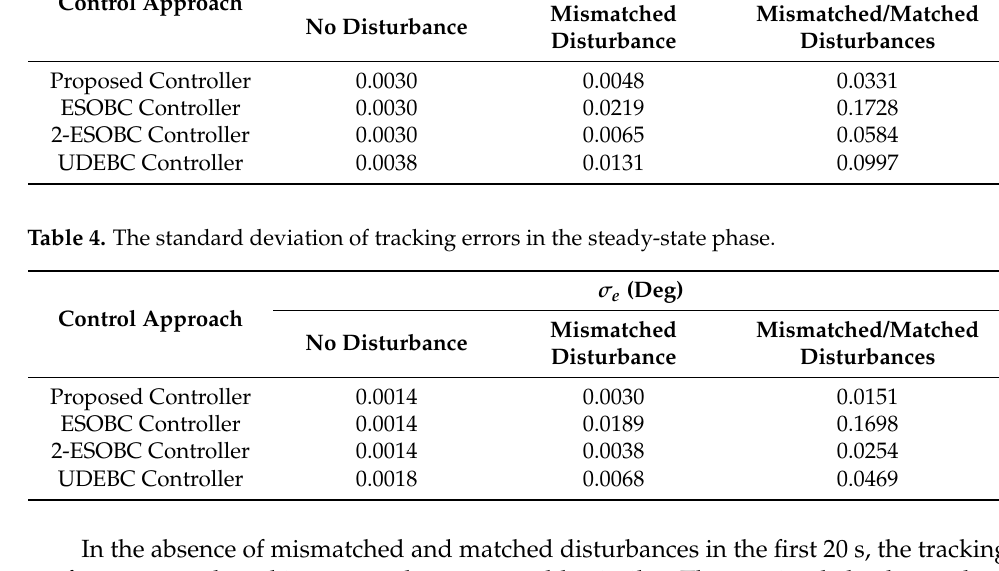
Table 3. The average tracking errors in the steady-state phase.